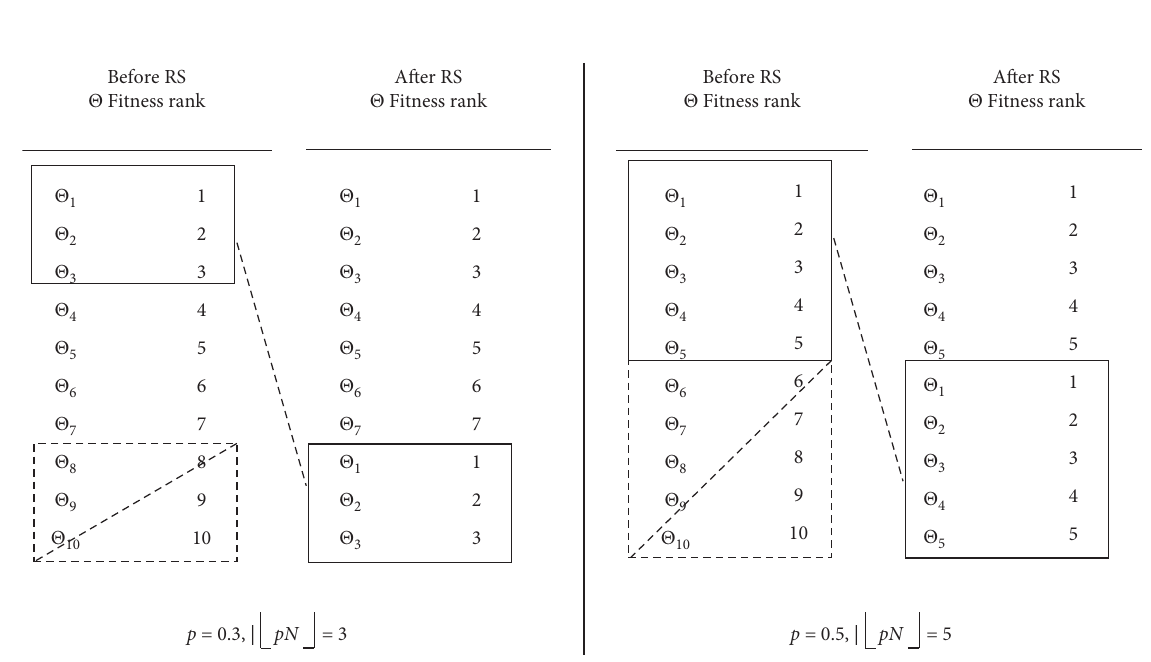
Figure 3: Demonstration of the RS operator with p � 0 . 3 and. p � 0 .